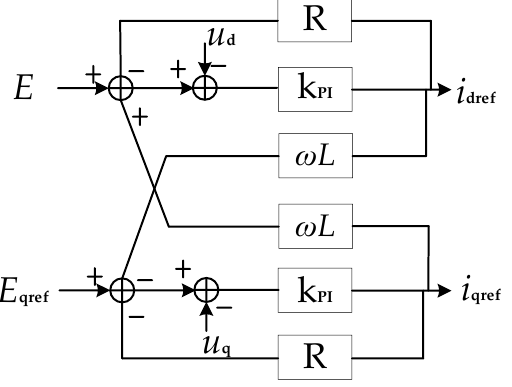
Figure 6. Stator electrical equation.